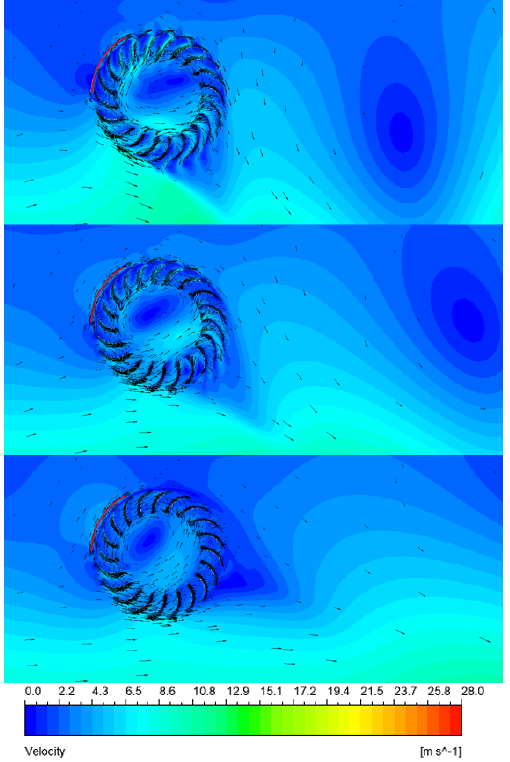
Figure 22. Velocity contours and vectors of Car Case 3 in the rotor zone taken at t = 4 s, t = 4.1 s and t = 4.3 s.